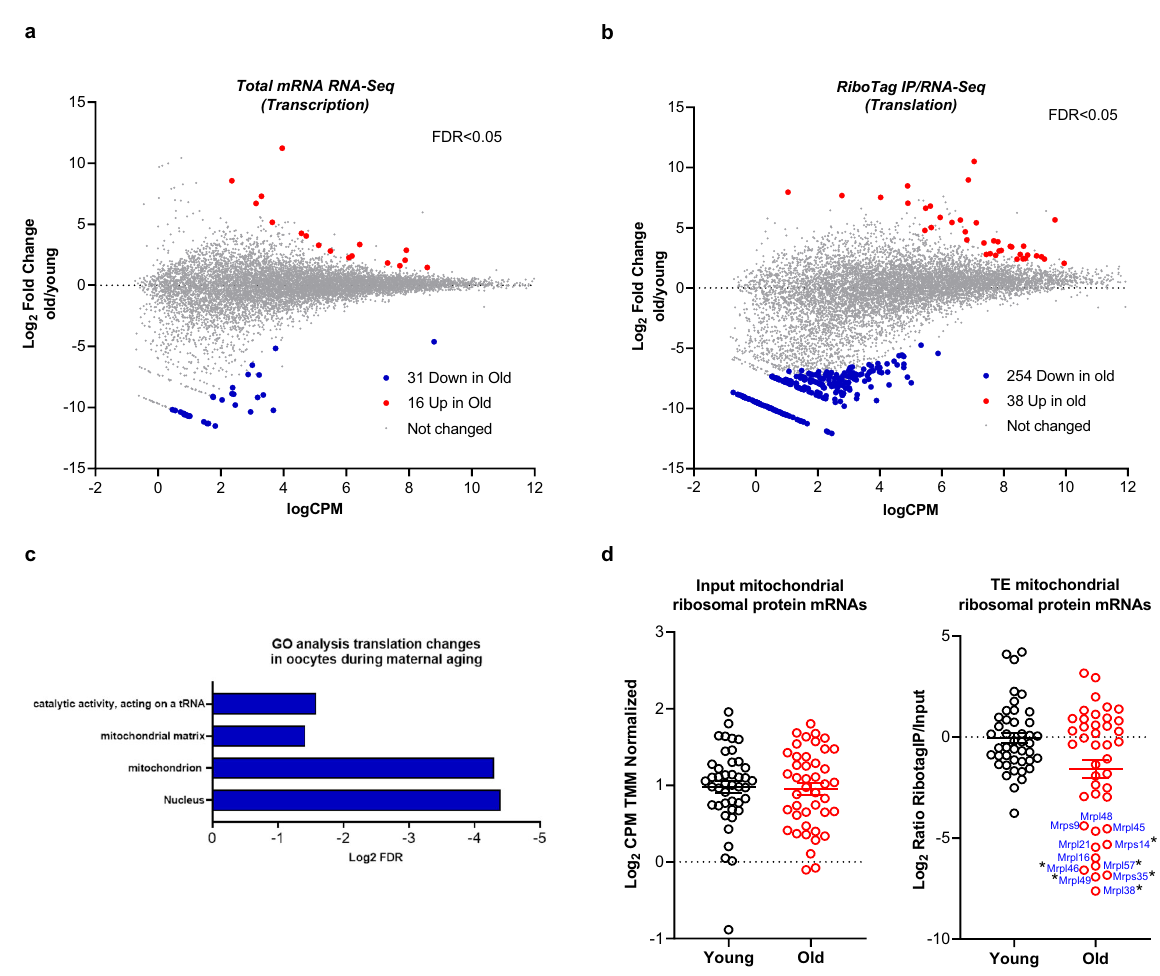
whose translation is signi fi cantly (FDR<0.1) different between young and old oocytes, including both upregulated and downregulated transcripts. Note the highly signi fi cant enrichment in mitochondrion term. d Comparison of levels of mRNAs coding for mitochondrial ribosomal protein and their translation ef fi - ciency (TE) in young and old oocytes. The log 2 of the average CPM is plotted on the y axis. The bar represents mean ± SEM. A subset of mRNAs coding